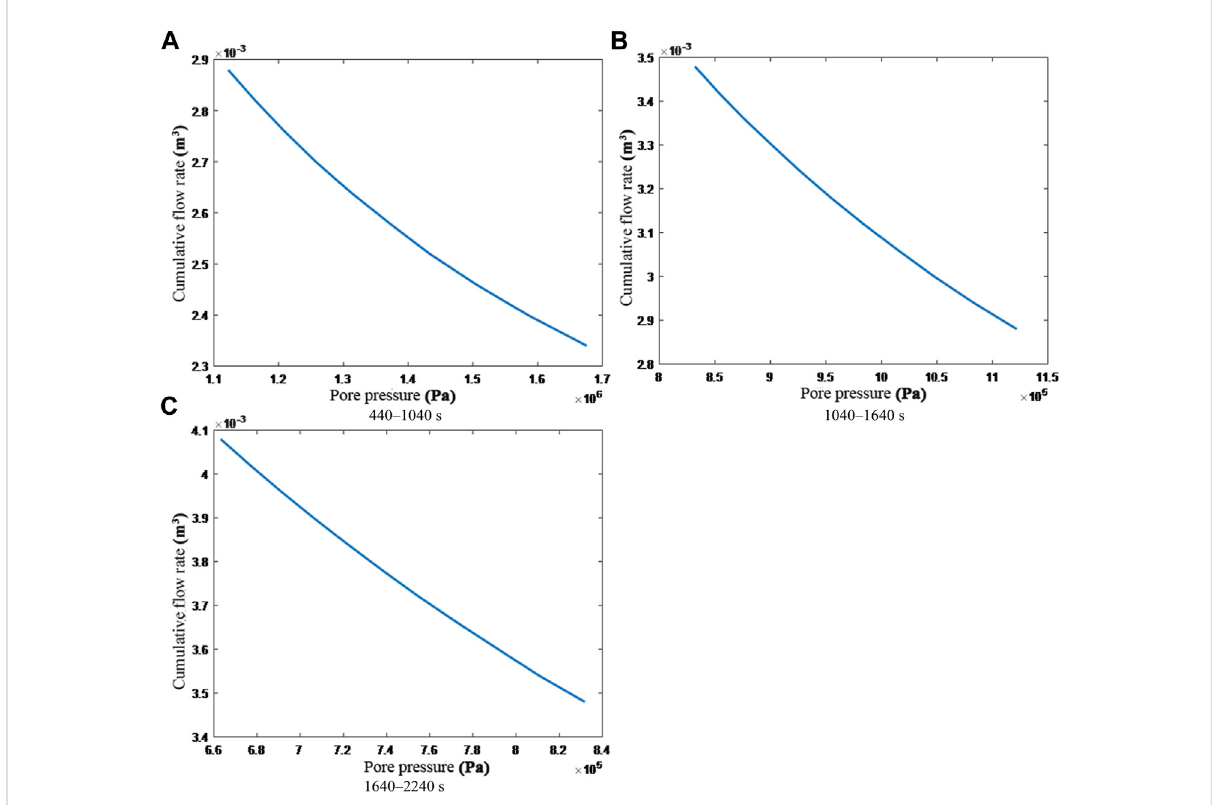
FIGURE 9 Curve of the change rate of the pore pressure.